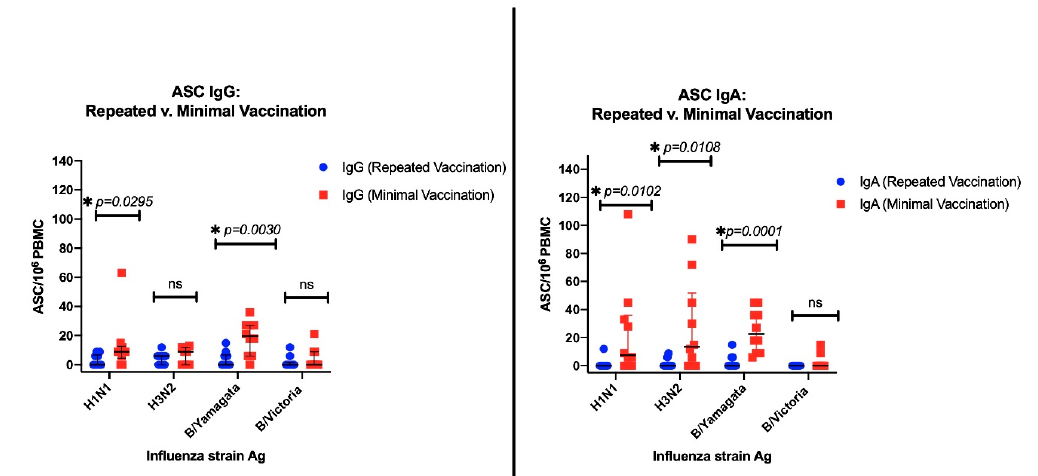
Figure 3. The left panel shows the IgG ASC magnitudes and the right panel shows the IgA ASC magnitudes, with blue dots representing the repeated vaccination group and red squares representing the minimally vaccinated group. The black error bars denote median and IQR. The asterisk (*) denotes a significant difference with p < 0.05, and “ns” denotes a non-significant difference.